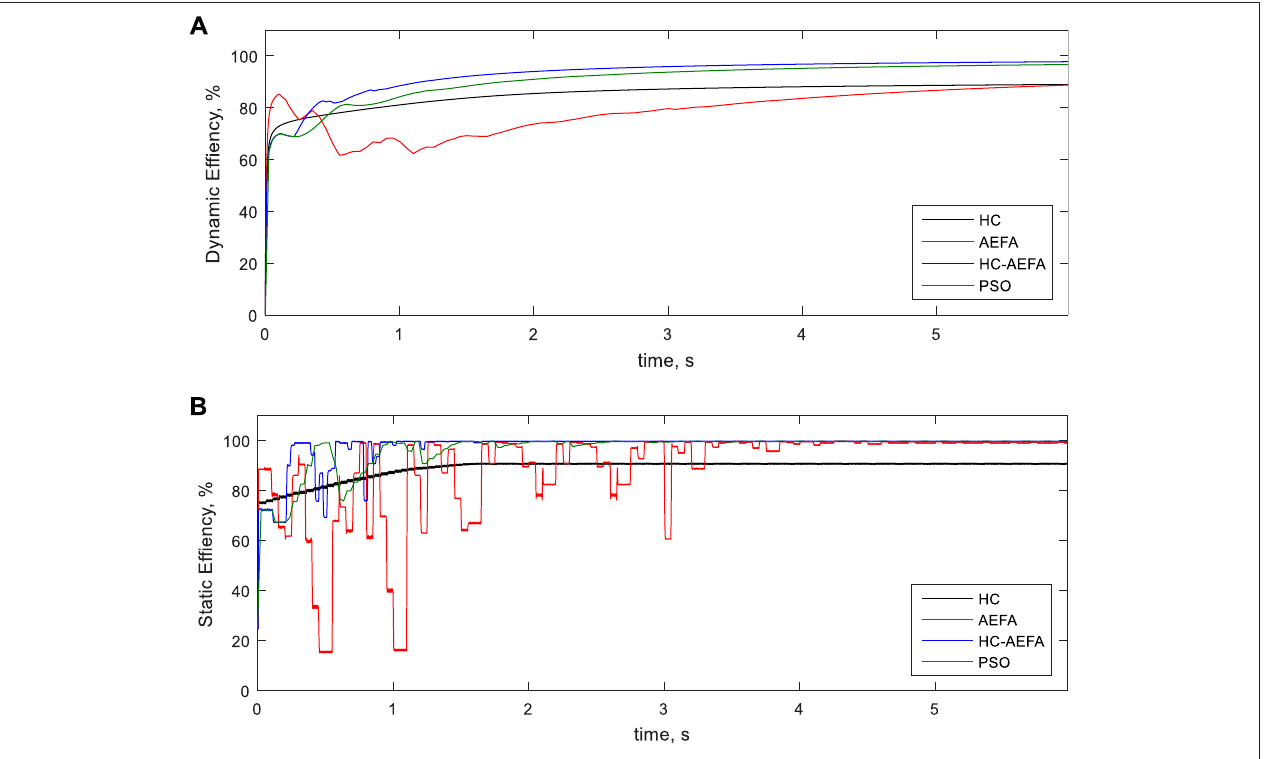
FIGURE8| Ef fi ciencycurvesatthe secondpatternobtainedusing theHC-AEFA,HC,AEFA, and PSOmethods; (A) Dynamic-ef fi ciency, and (B) Static-ef fi ciency.